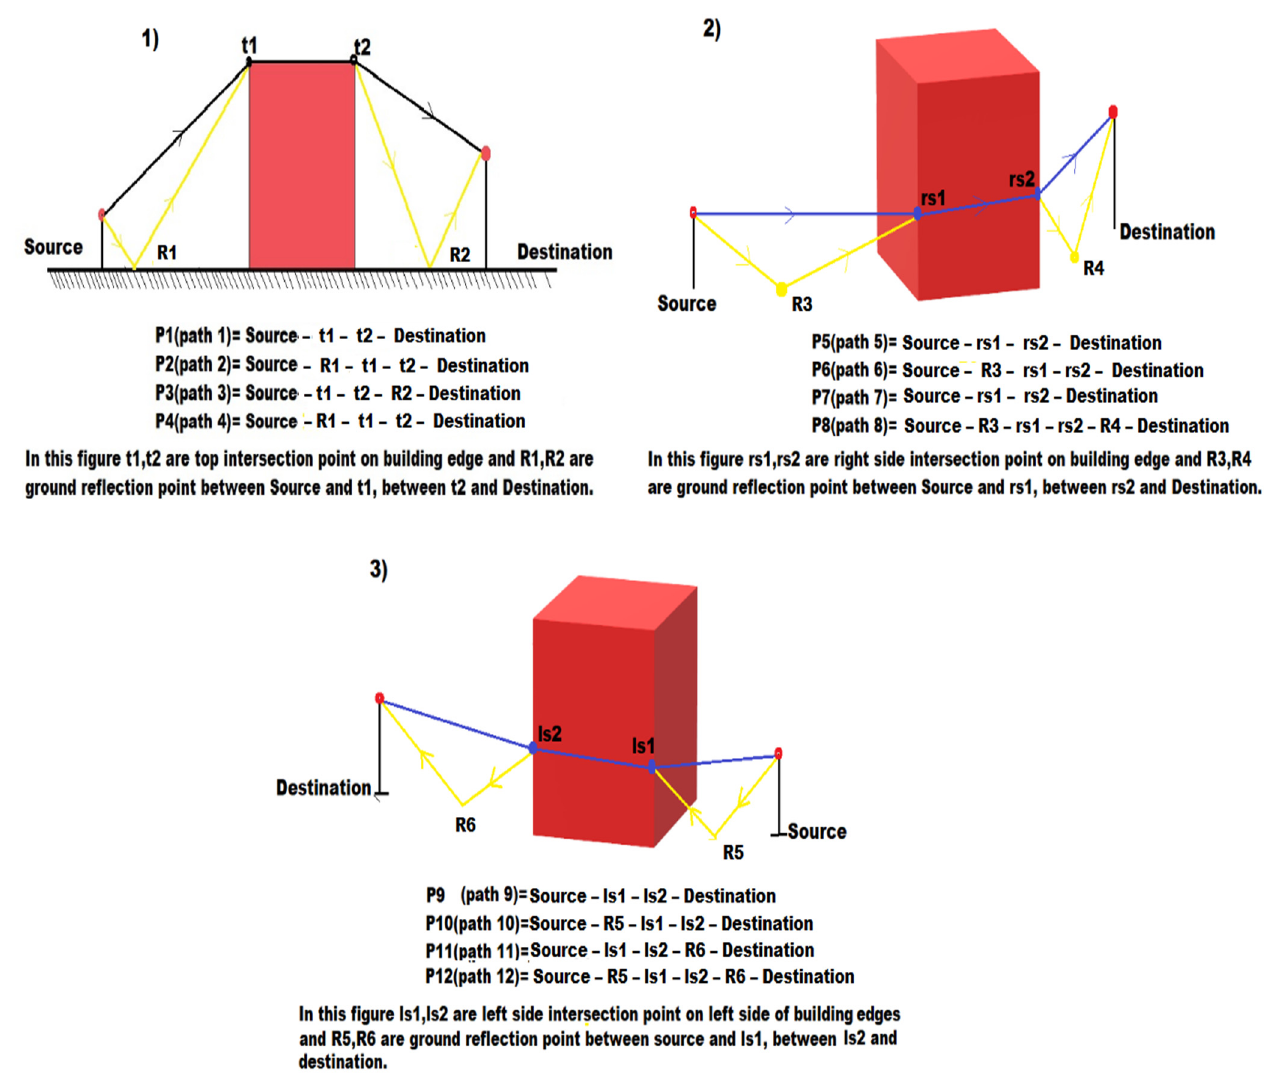
Figure 11. Principal path of propagation explaining diffraction and reflection. Determination of signal strength equation: This step determines the equation for finding the signal strength at any location. The equation is fitted analogously to the semi- empirical formulae used in sound propagation modeling.